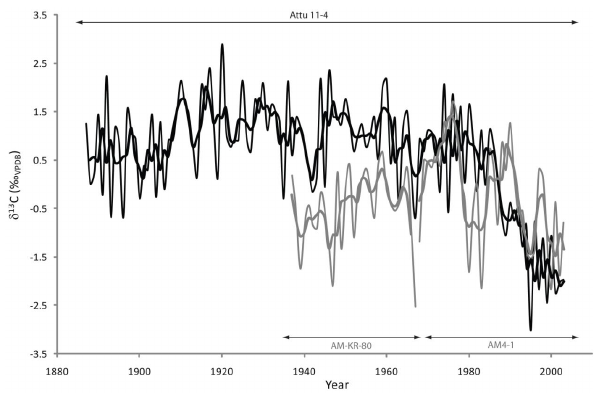
13 C values for three Clathromorphum Figure 4. 611 Fig. 4. Annually-resolved δ nereostratum specimens collected offshore of the Aleutian Islands with 3-year running mean in